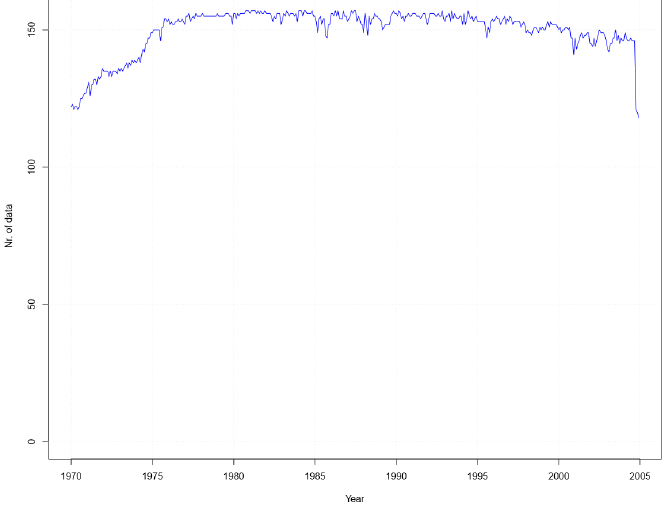
Figure 2. Overall number of available precipitation series per year.